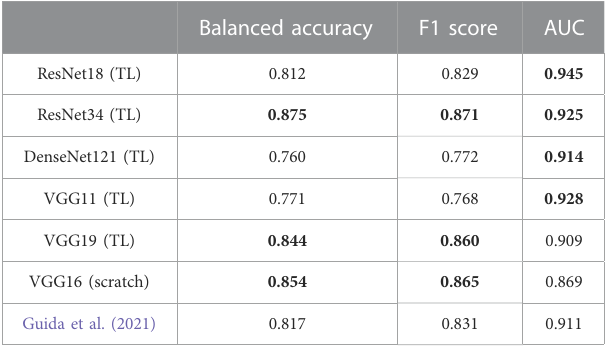
TABLE 5 Comparison between the best-performing models in this study and the model in an existing